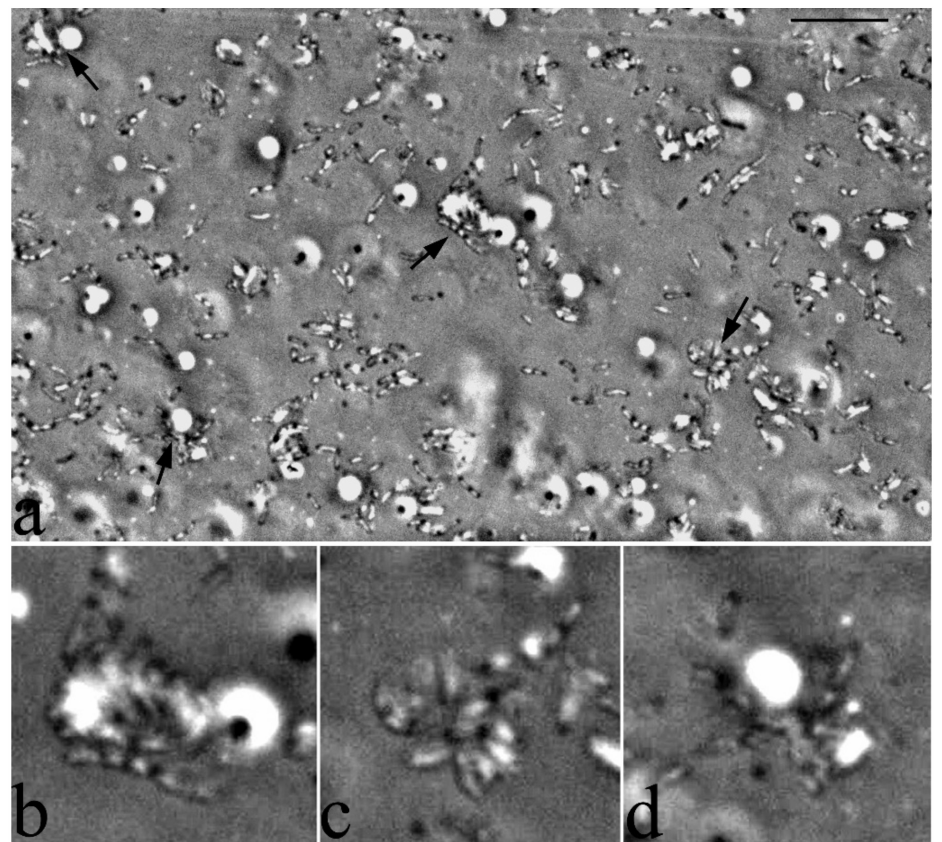
Figure 8. Strain S8 on hexadecane 4 days of growth. Bacterial microconglomerates formed around a certain central core with refractory properties. Indicated by arrows ( a ) and on enlarged fragments ( b – d ). Light microscopy, phase contrast. The length of the scale mark ( a ) is 10 µ m. The cells of the R. qinqshengii VT6 strain, when cultivated on a rich medium, have a regular rod-like shape, which is also characteristic of other representatives of this genus.